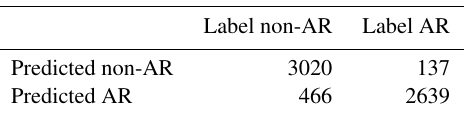
Table B3. Confusion matrix of the method for the testing set – the CAM5.1 data (3-hourly, 200km). It shows the number of correctly recognized (the diagonal) and the number of incorrectly classified events (off-diagonal).